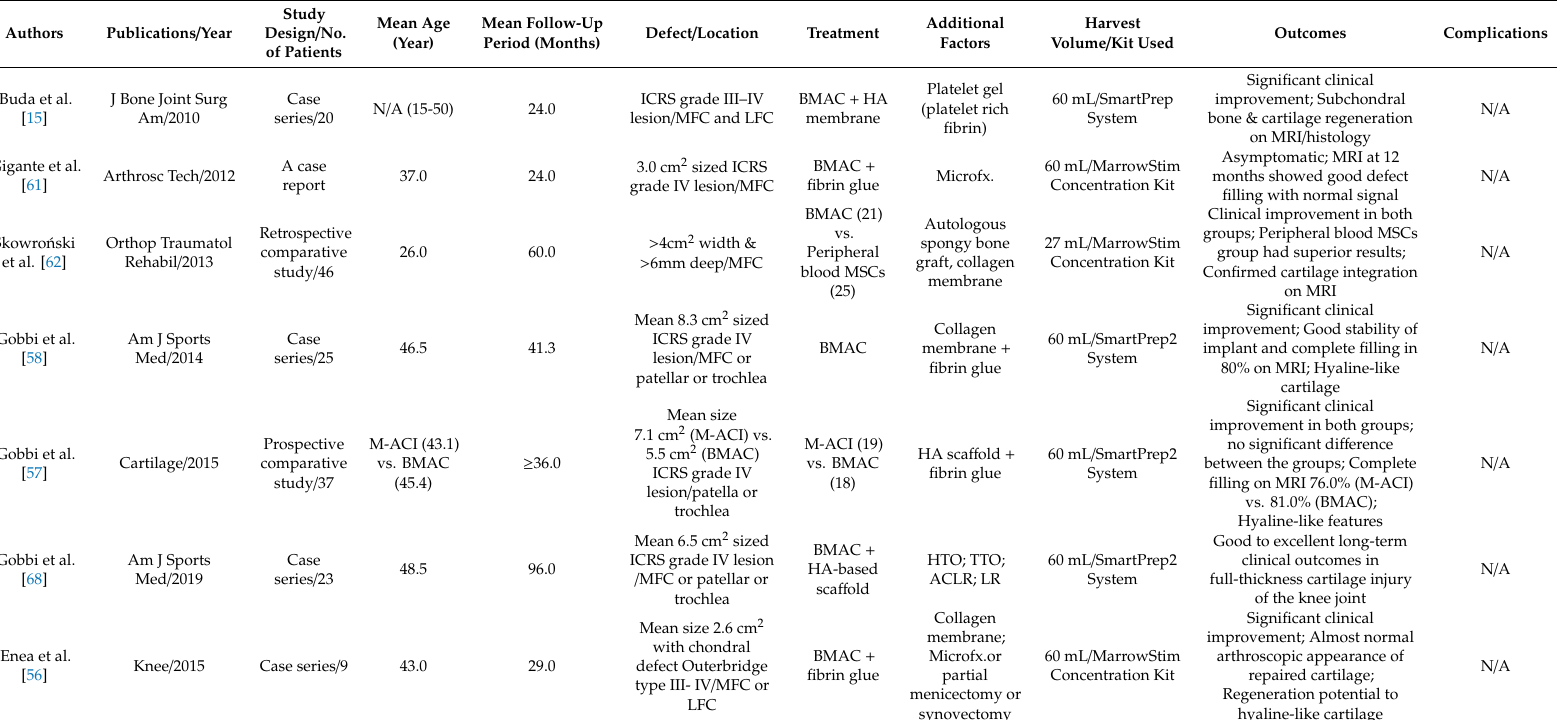
Table 2. Details of the clinical trials of BMAC focusing on cartilage